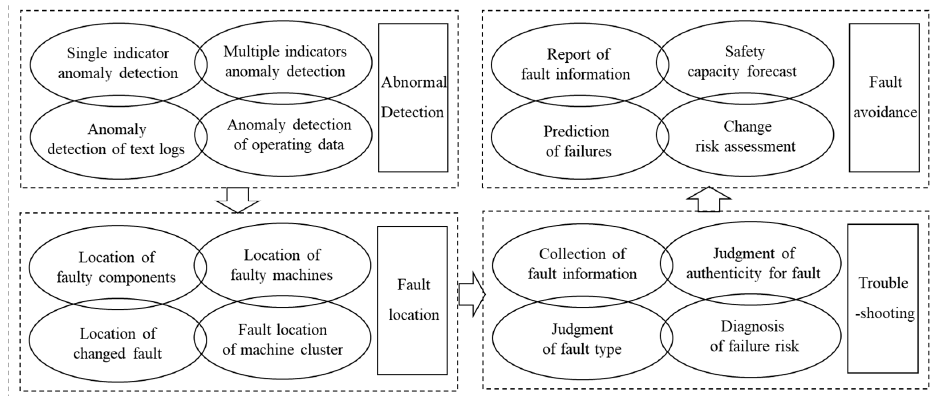
Figure 10. Dynamic decision-making component of intelligent equipment group operation and maintenance of the system. Dynamic decision-making components are based on the well-mined knowledge map of safe man-machine system operation and maintenance. It is an important means for realizing the intelligent control, operation, and maintenance of the equipment group.